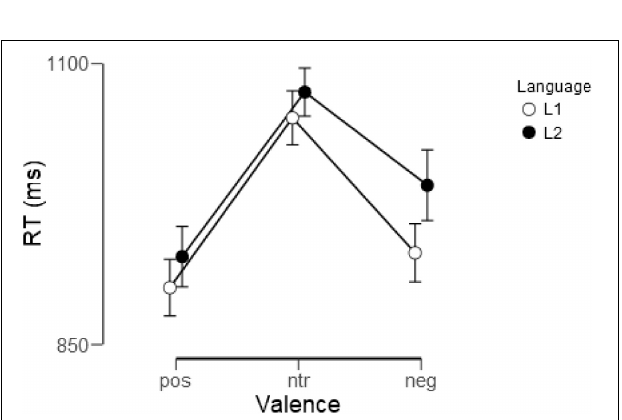
FIGURE 2 | Reaction times (RT) for evaluation of positive (pos), neutral (ntr), and negative (neg) words in L1 (German) and L2 (English). Shown are means and standard errors.